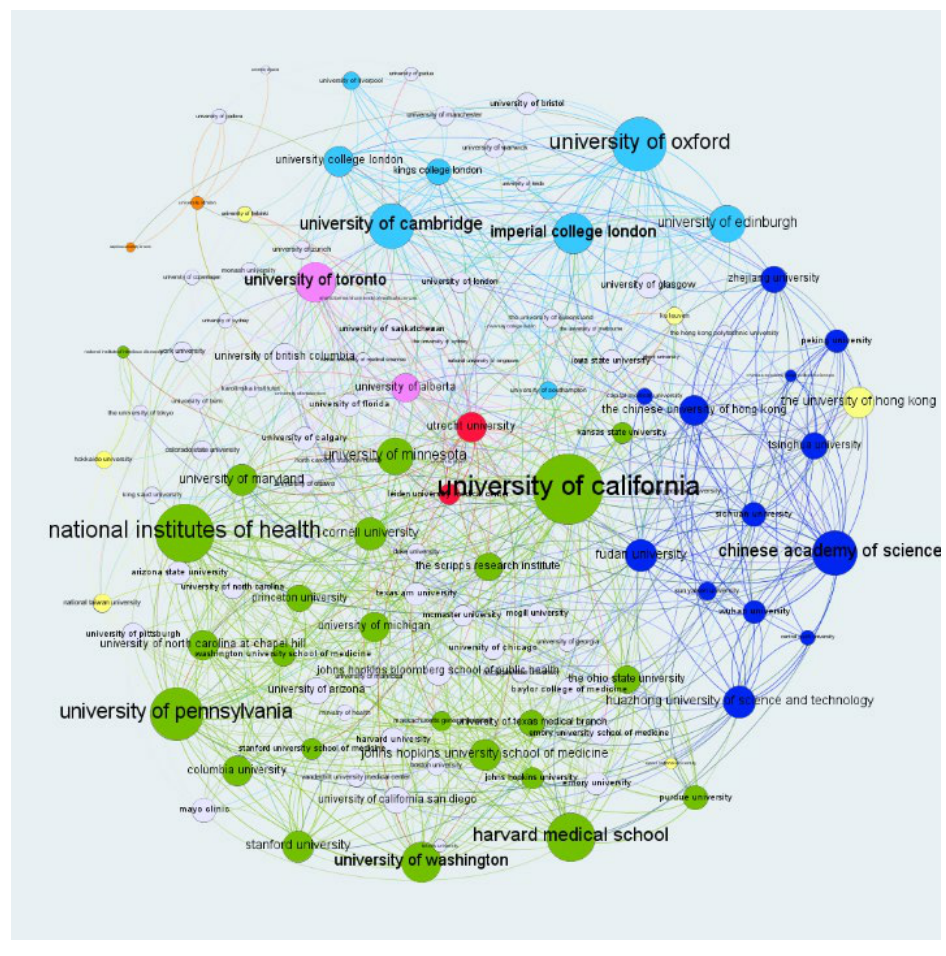
Figure 1 The institution collaboration network. Colors indicate country/region: blue—China, green—United States, light blue—United Kingdom, pink—Canada, yellow—Hong Kong, and